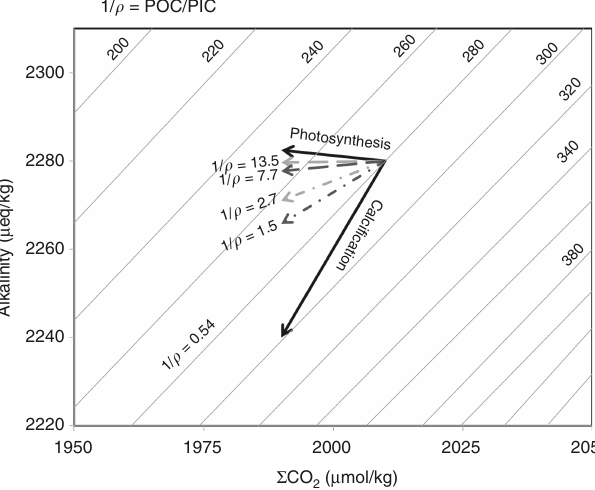
Fig. 5 In fl uence of soft tissue and carbonate counter pumps on the CO 2 partial pressure of surface waters, as a function of the POC/PIC rain ratio (1/ ρ ). Solid black line isocontours represent p CO 2 ( μ atm) for constant salinity (34 ‰ ), temperature (14 °C), and depleted phosphate (0.5 µ mol/ kg) and silicate (3 µ mol/kg) contents. The solid black arrows represent the effect of biogenic export production in the case of photosynthesis and calci fi cation only. The dashed (or dot-dashed) black and grey arrows illustrate the in fl uence of the biological pump (and particularly the CCP) during the HS1 relative to the ACR, i.e., when 1/ ρ decreases by a factor of 1.8, assuming that 10 (or 50%) of the exported POC has been preserved within the sediment, i.e., under two probable export production conditions at site